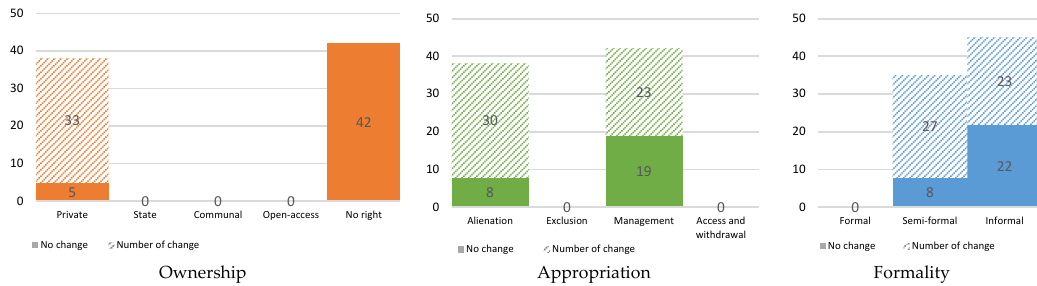
Figure 5. The number of property rights transformation on cultivated lands in KHI.